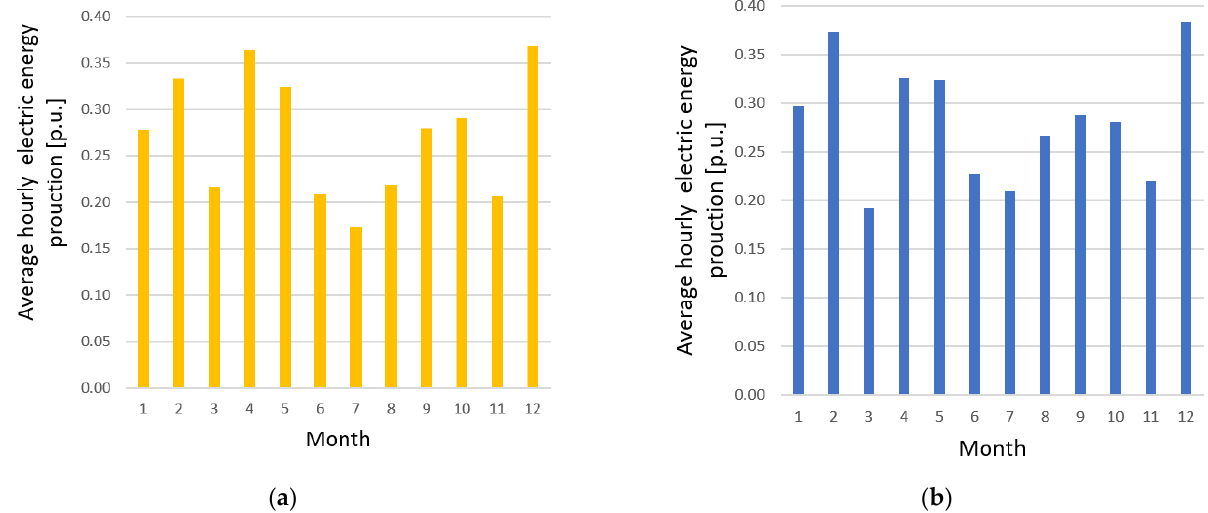
Figure 5. ( a ) Seasonal variability of electrical energy production of Wind Farm A; ( b ) Seasonal variability of electrical energy production of Wind Farm B.